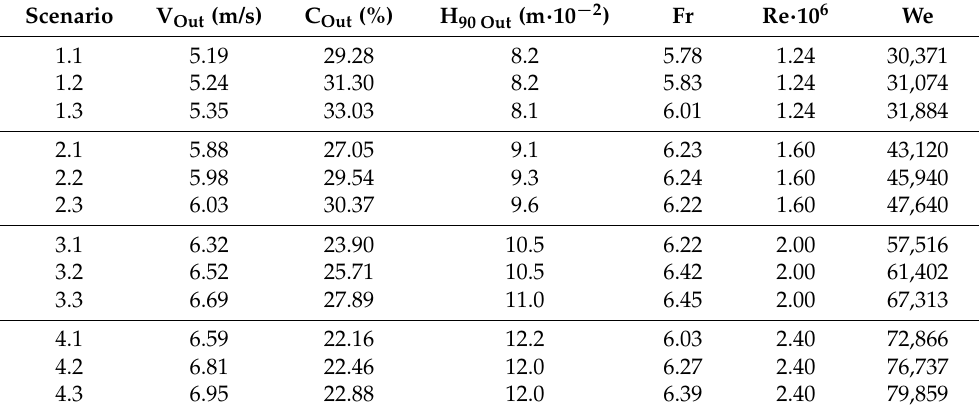
Table 2. Average velocity, concentration and H 90 values at the channel